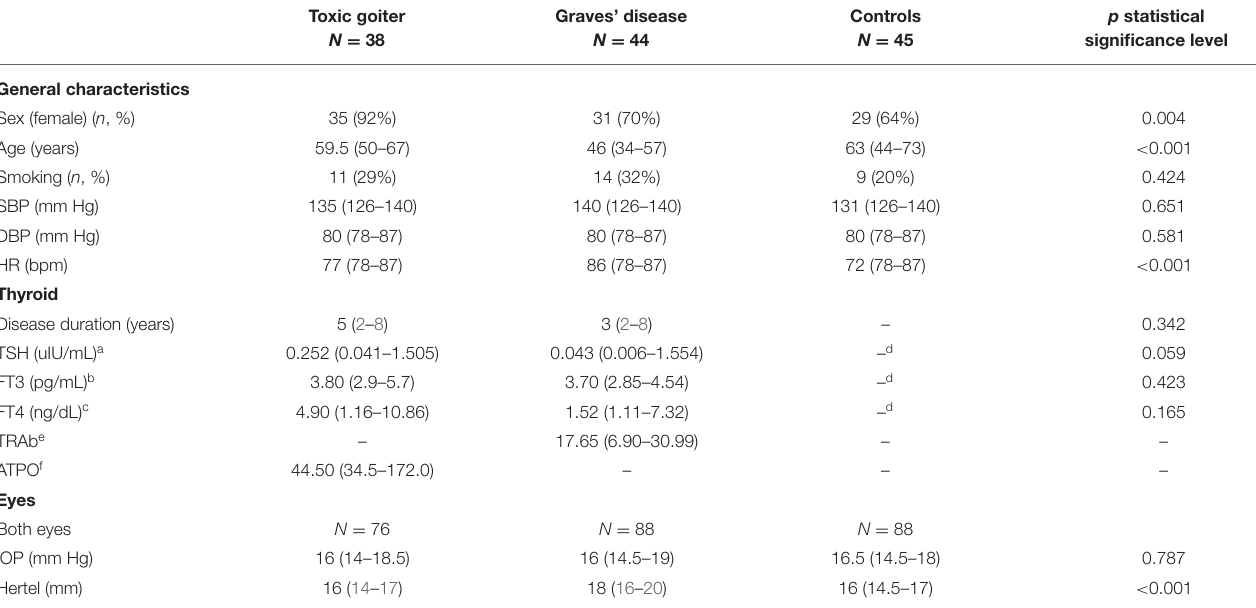
TABLE 1 | Group characteristics: systolic (SBP) and diastolic blood pressure (DBP), heart rate (HR), TSH, FT3, FT4, intraocular pressure (IOP), exophthalmometry (Hertel), sex distribution, disease duration, and smoking status.